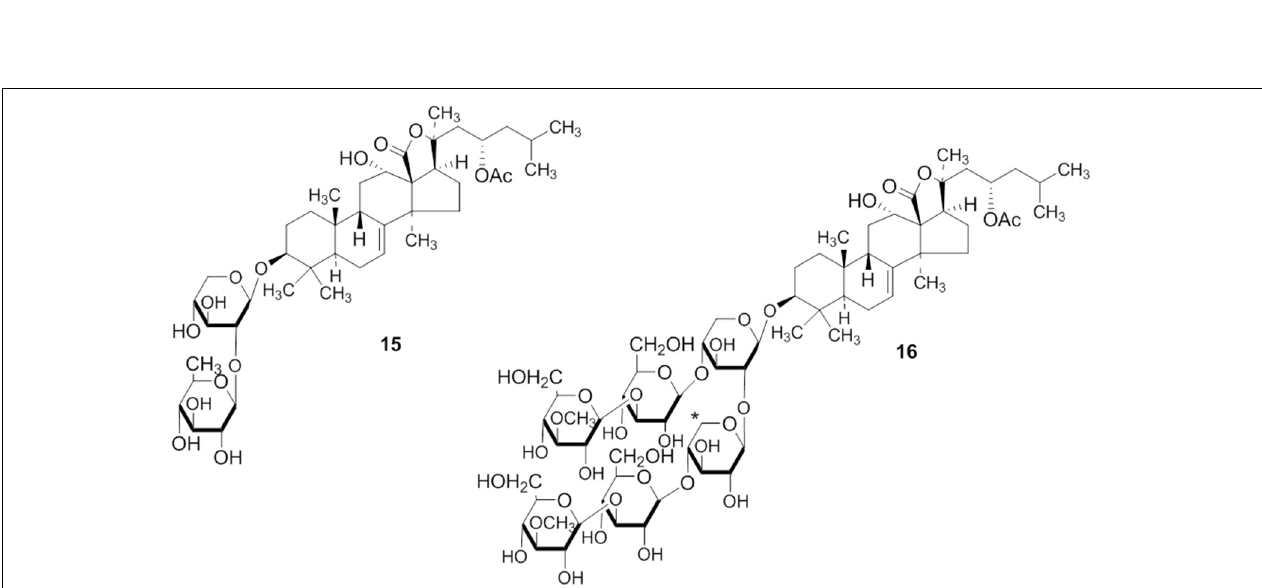
FIGURE 6 | The structure of 15 is